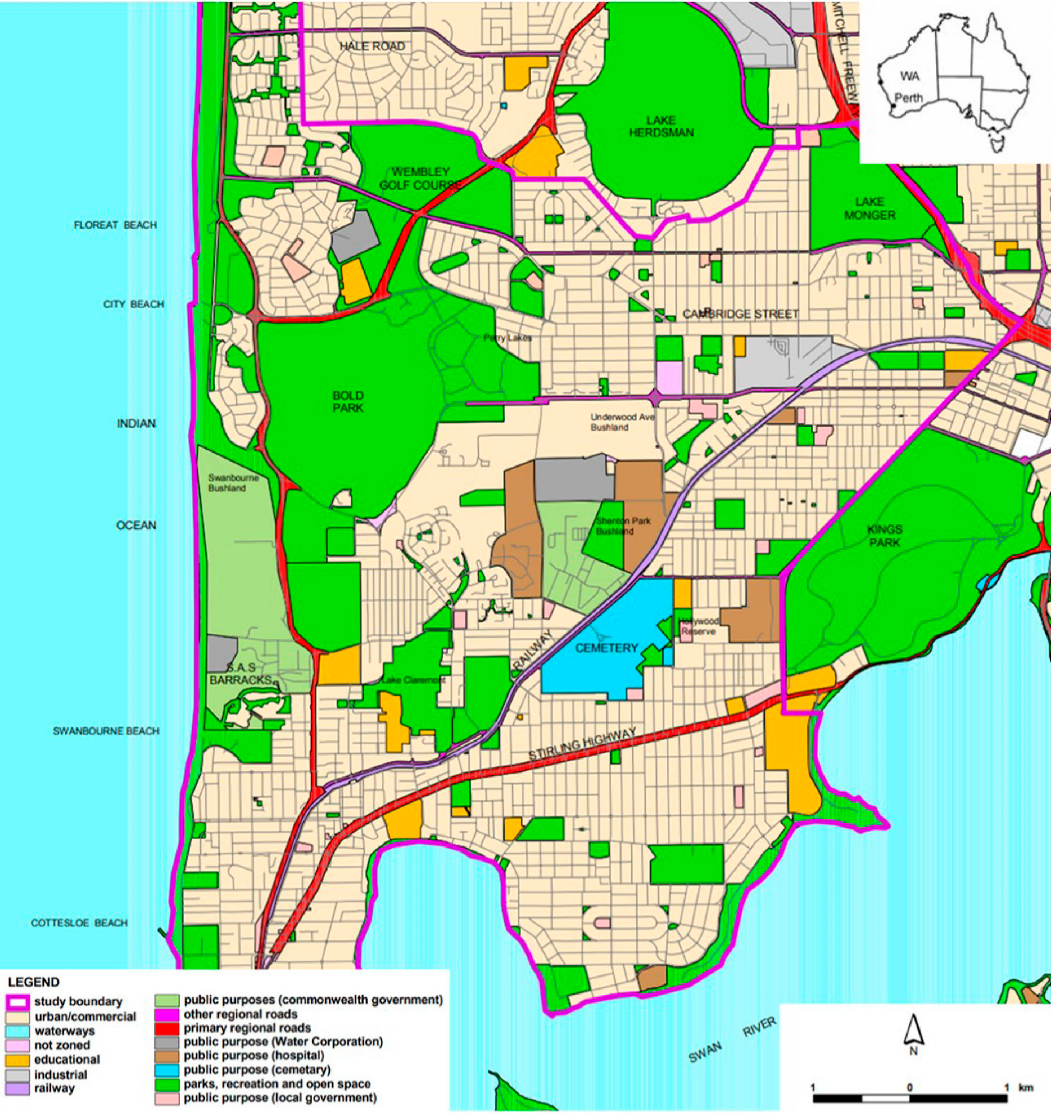
Figure 1. Location of the Lake Claremont public green infrastructure (PGI) space in relation to adjacent green infrastructure. The Perth Central Business District is located immediately east–north-east of the Kings Park PGI space. Adapted from the Western Suburbs Regional Organisation of Councils (WESROC) Greening Plan 2002